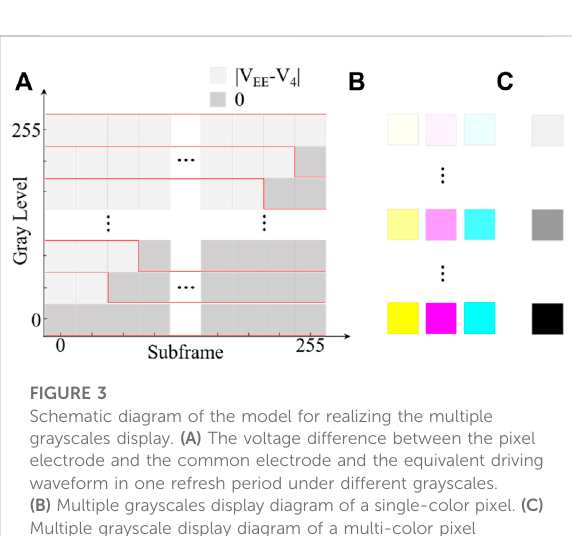
FIGURE 3 Schematic diagram of the model for realizing the multiple grayscales display. (A) The voltage difference between the pixel electrode and the common electrode and the equivalent driving waveform in one refresh period under different grayscales. (B) Multiple grayscales display diagram of a single-color pixel. (C) Multiple grayscale display diagram of a multi-color pixel superimposed by three